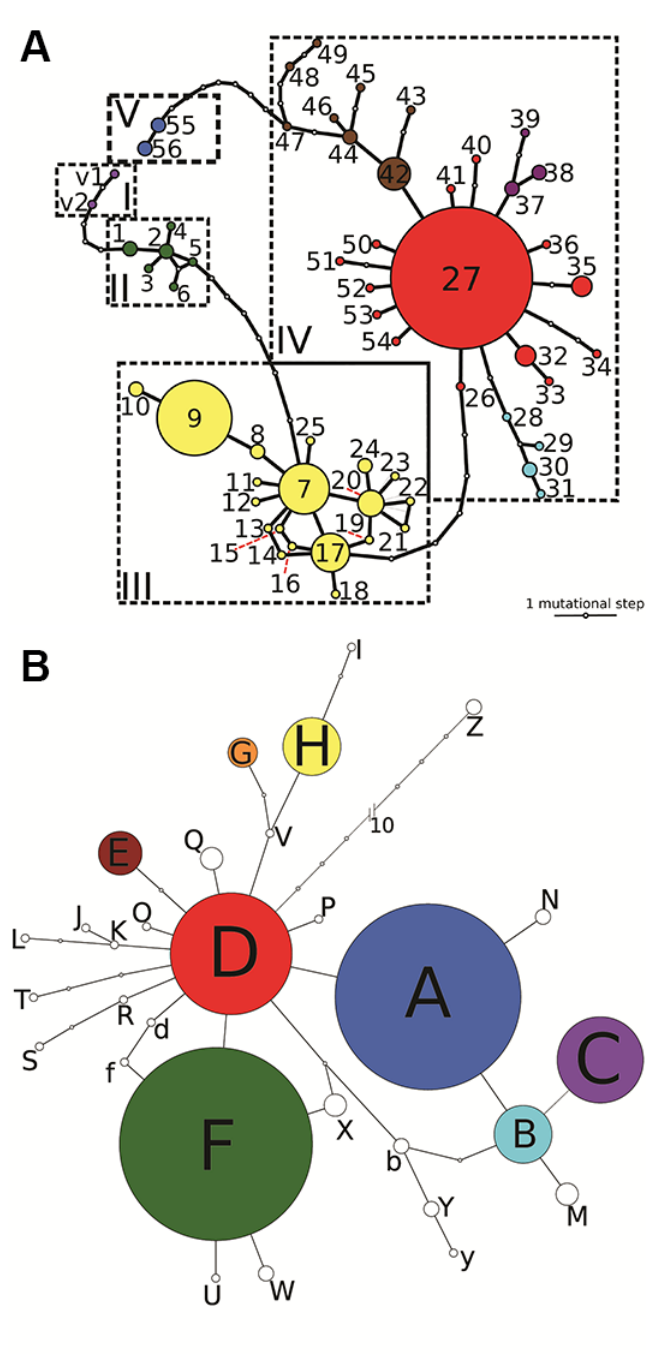
Figure 2 Haplotype and ribotype networks reconstructed based on the combined plastid DNA dataset ( A ) and nrITS ( B ) with a 95% maximum connection limit in Primula vulgaris s. l. and the outgroup. The size of each circle is proportional to the frequency of the haplotype or ribotype in our datasets. Small unlabeled circles represent hypothetical haplotypes and ribotypes that were not sampled. The main groups of haplotypes ( A ) are denoted by Roman numerals (see Table